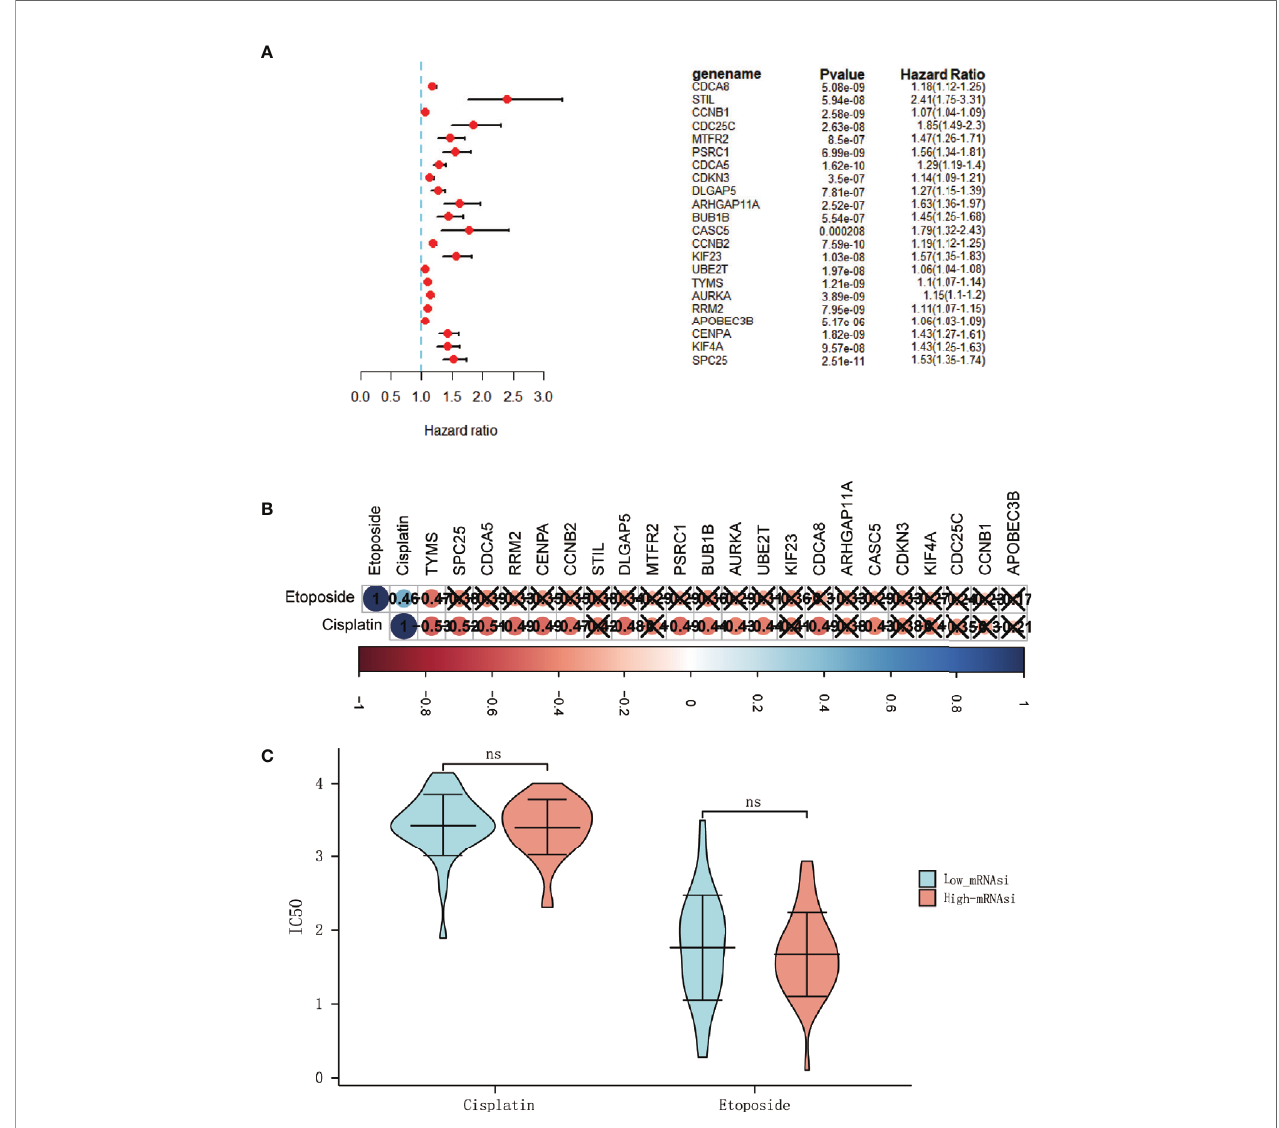
FIGURE 5 | The hub genes associated with overall survival (OS) in ACC patients. (A) Univariate Cox regression analysis between hub genes and OS in ACC patients. (B) Correlation analysis between 22 hub genes and IC50 of cisplatin and etoposide ( × means P > 0.05). (C) Differential analysis of the IC50 of the cisplatin and etoposide between high-mRNAsi and low-mRNAsi groups. (ns, not signi fi